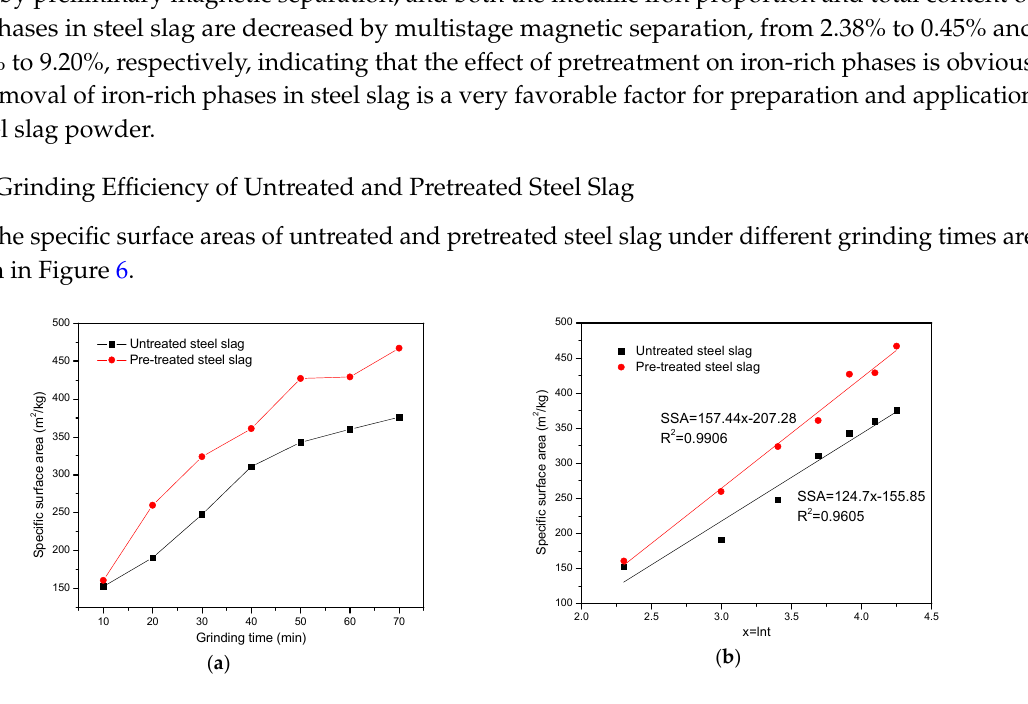
Figure 5. The technical flow process of recycling iron-rich phases in steel slag.